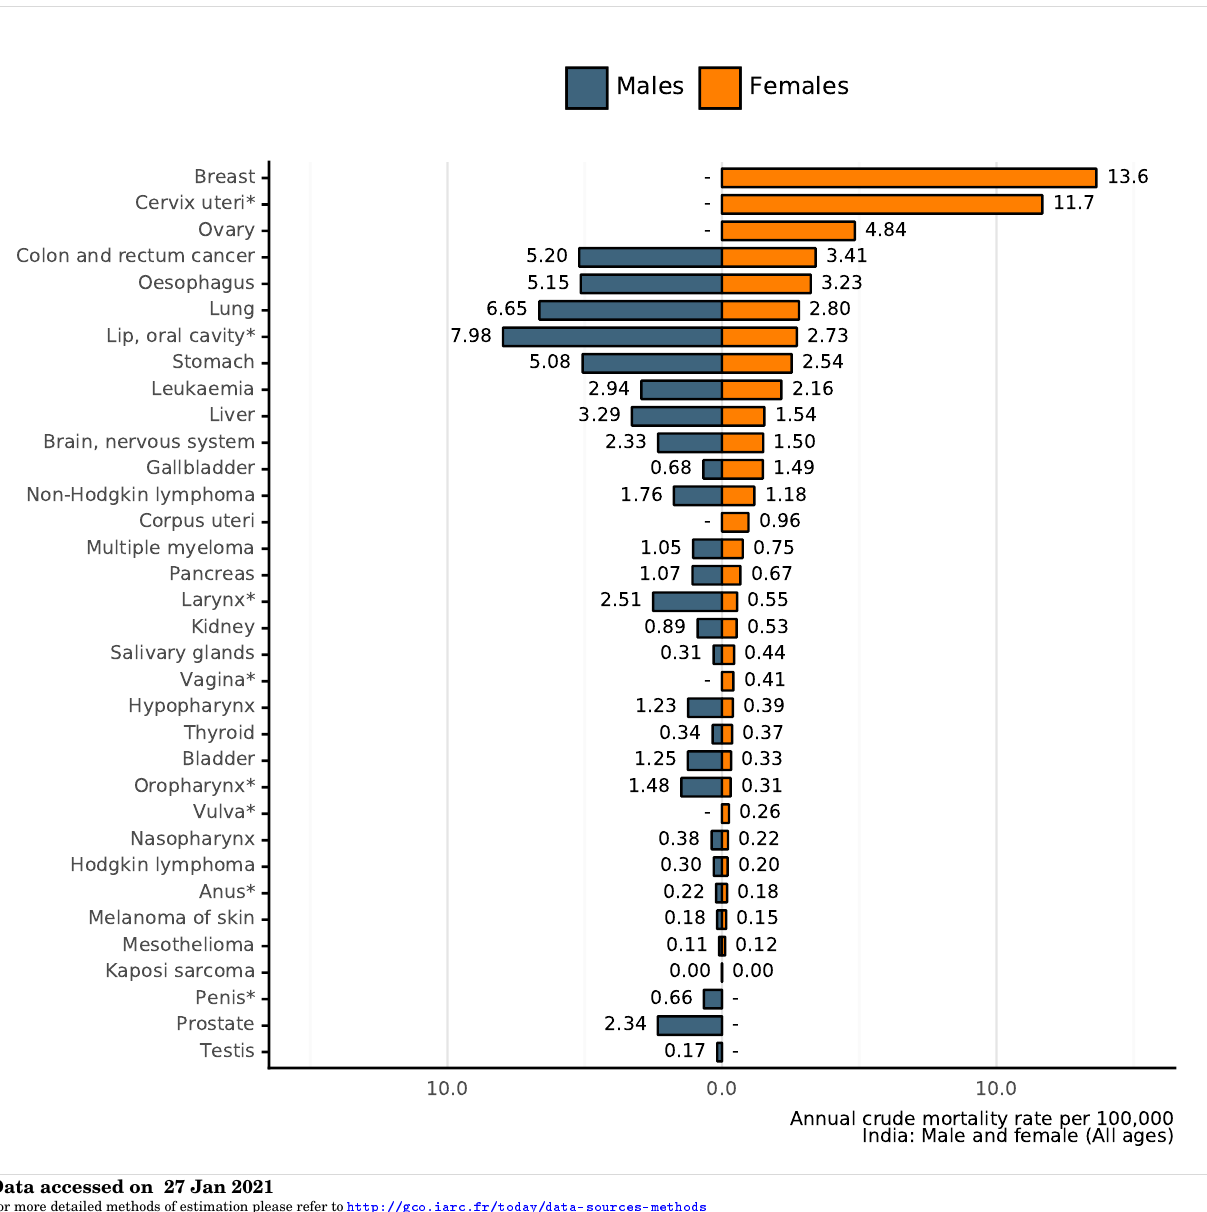
Figure 6: Comparison of HPV related cancers mortality to other cancers in men and women of all ages in India (estimates for